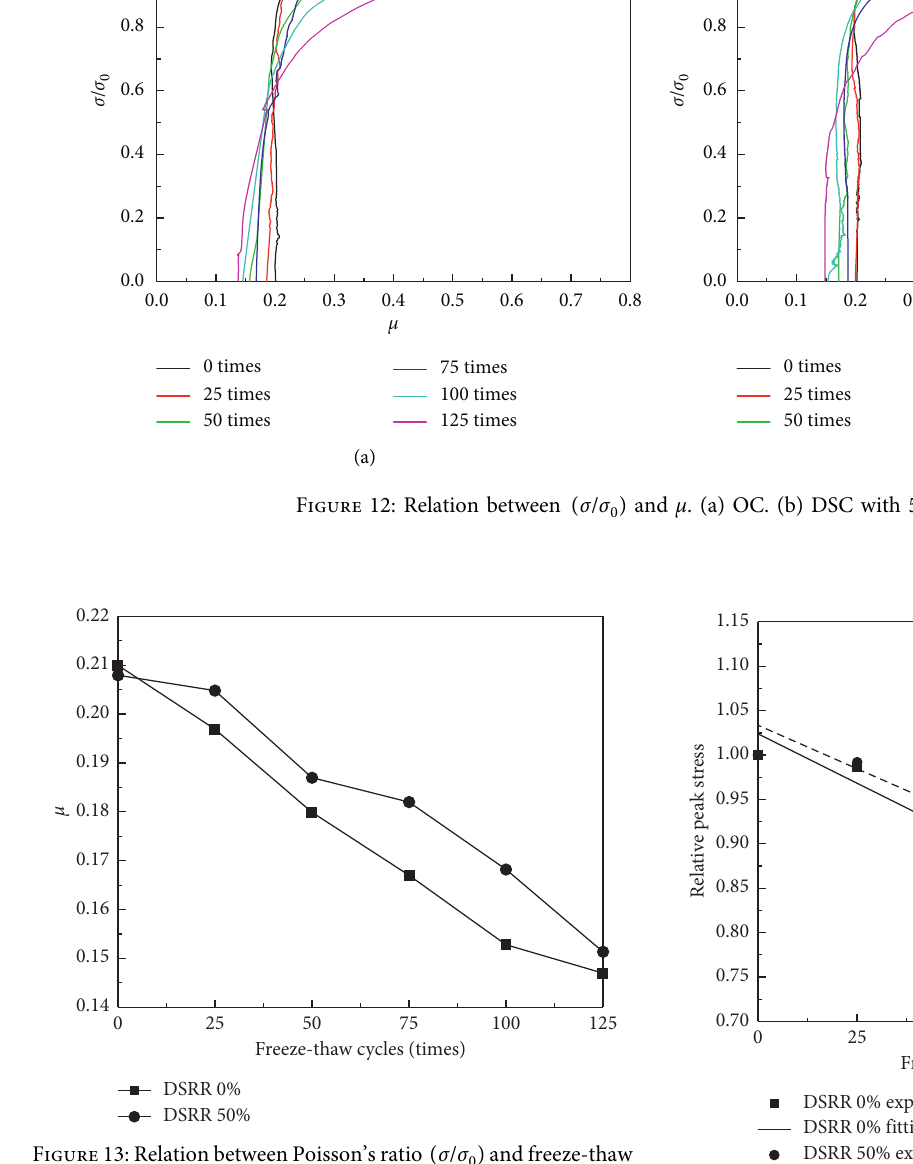
) and freeze-thaw 0